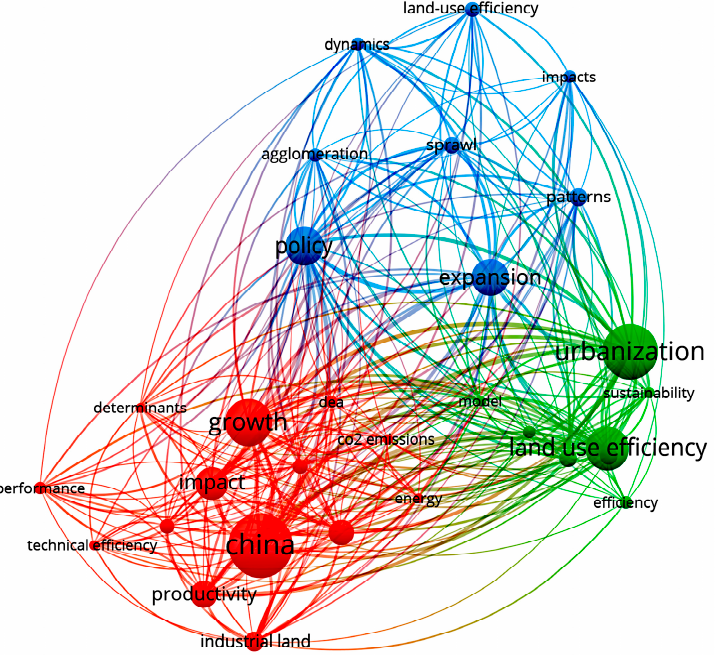
Figure 5. Knowledge graph of keyword co-occurrence in the literature (keywords that appear 10 times are clustered into 3 categories).